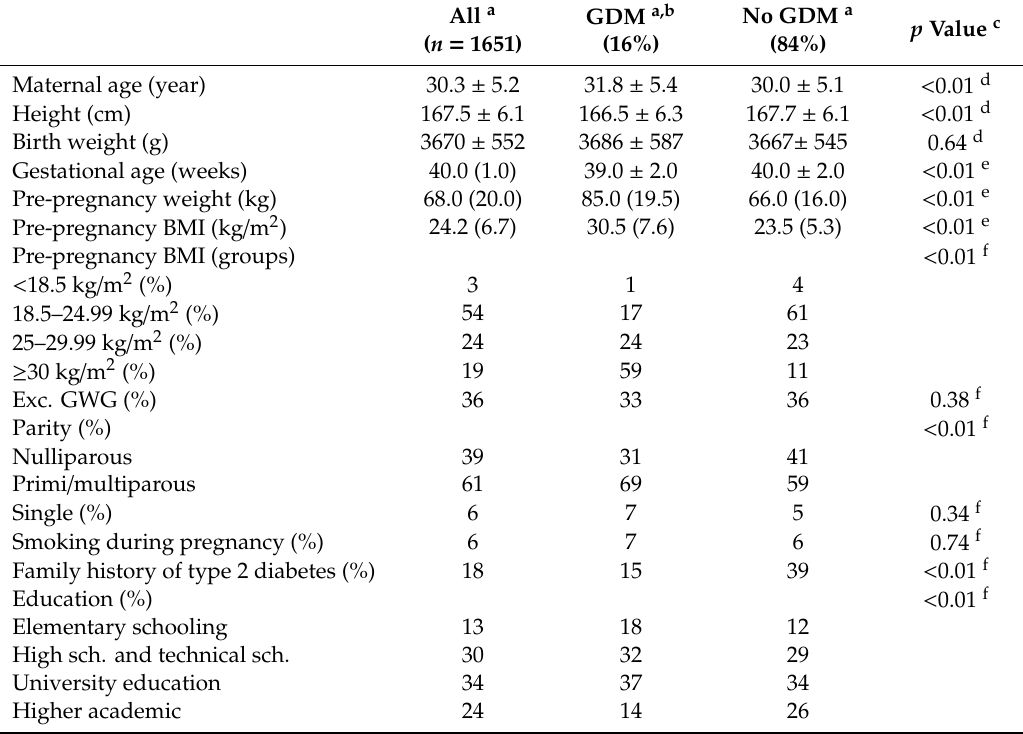
Table 1. Birth outcomes and characteristics of mothers at baseline in relation to gestational diabetes mellitus diagnoses.